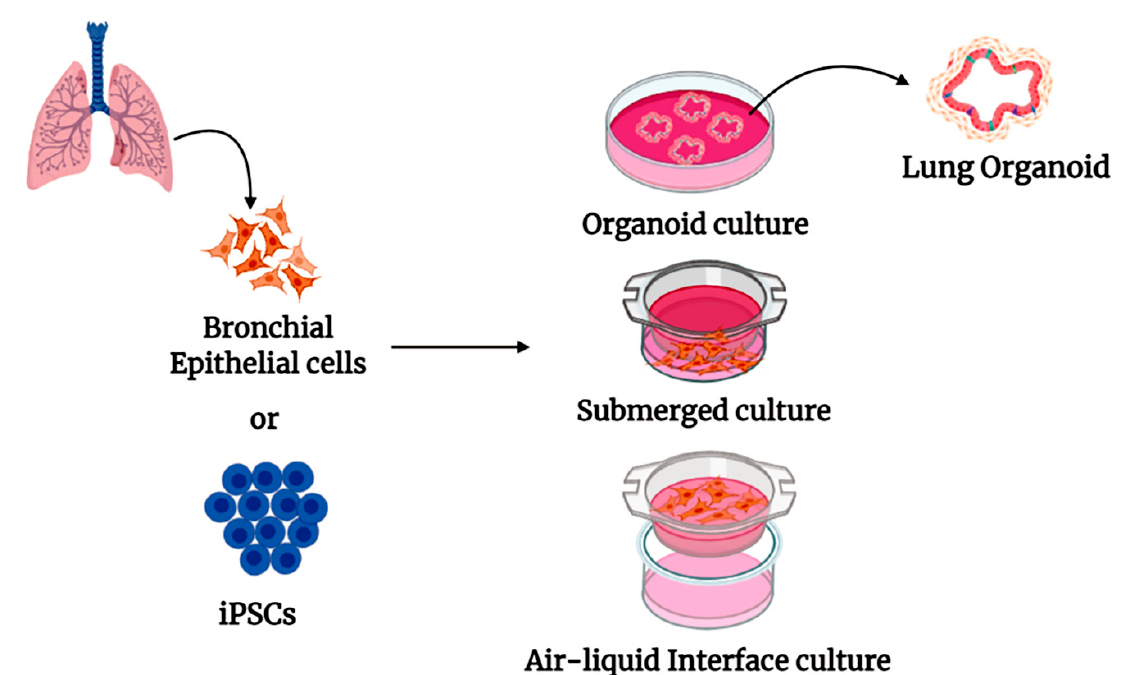
Figure 3. Schematic illustration of isolated lung epithelial cells or induced pluripotent stem cells (iPSCs) for studying SARS CoV-2 virus pathogenesis, using organoid culture, submerged culture, and air–liquid interface (ALI) culture of epithelial cells.